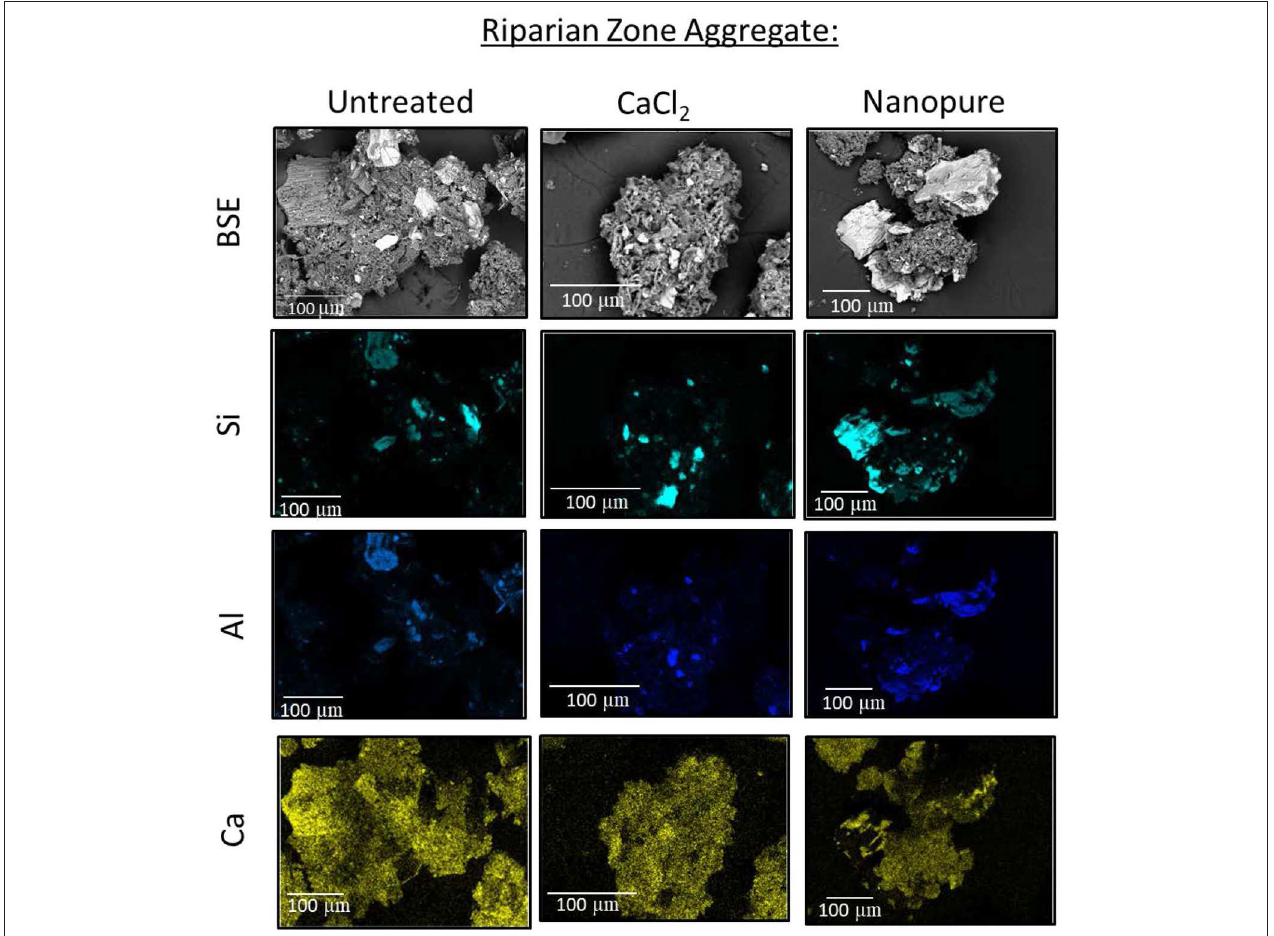
FIGURE 5 | Representative riparian zone (RZ) aggregate as a backscatter electron (BSE) image. Maps show the distribution of specific elements in untreated air-dried samples ( left ), treated with high ionic strength CaCl 2 solution ( center ), and low ionic strength Nanopure water ( right ).